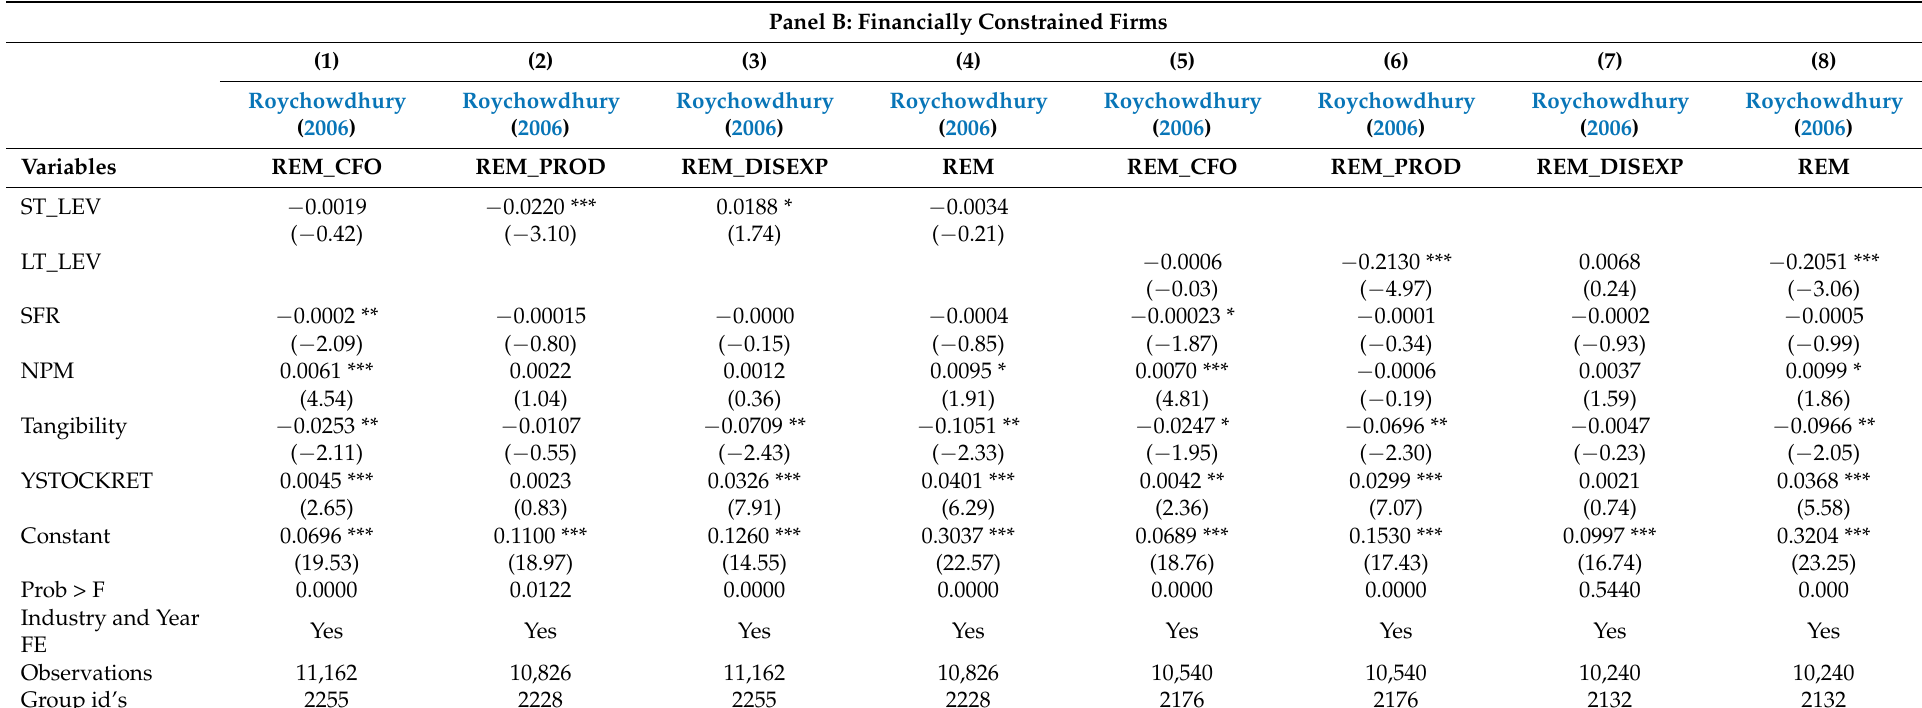
Table 6 report the results of the impacts of short-term and long-term leverage (ST_LEV and LT_LEV, respectively) on REM practices in context of panel B (financially constrained firms). t-statistics are informed in parentheses. ***, **, and * indicates the p < 0.01, p < 0.05, and p < 0.1,